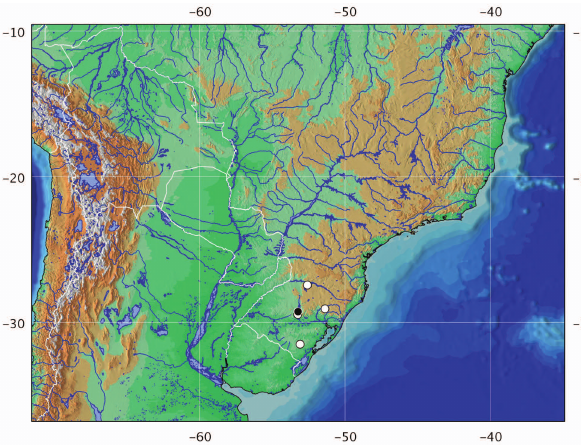
Fig. 3. Map of central and southeastern South America showing the collecting sites (open dots) and the type-locality (black dot) of Oligosarcus jacuiensis